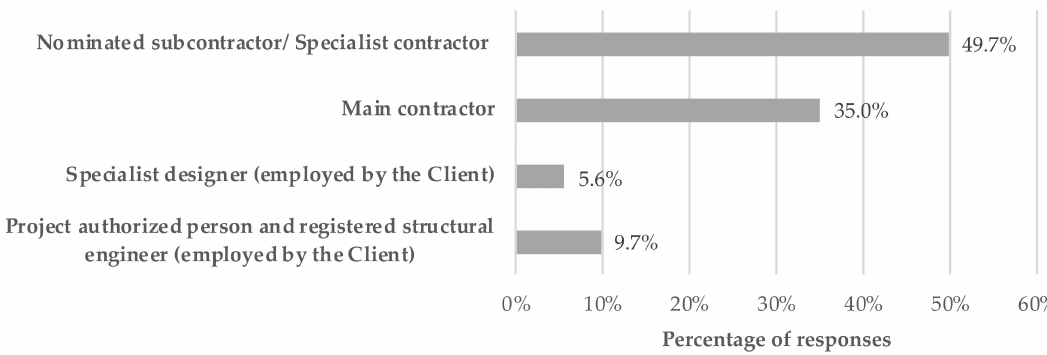
Figure 3. Percentage of project parties who undertake the design responsibilities of the external stone cladding system and prepared the statutory submissions in private projects ( n = 53).